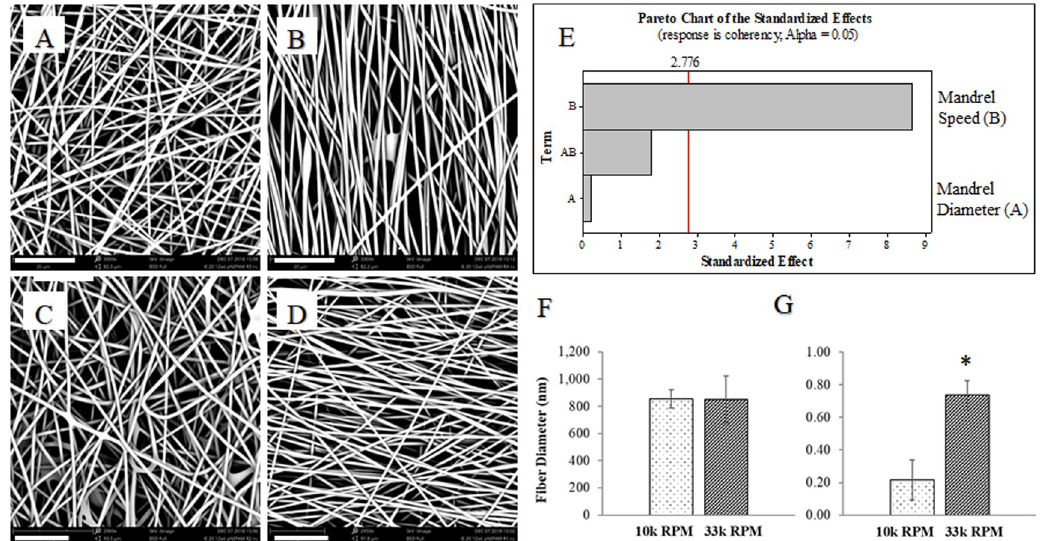
Fig 3. Effect of mandrel diameter and speed on fiber diameter and coherency. (A) 0.156” (4mm) mandrel diameter, 10,000 RPM. (B) 0.156”, 33,000 RPM. (C) 0.195”, 10,000 RPM. (D) 0.195”, 33,000 RPM. (E) Factorial design analysis shows mandrel speed to be a significant factor on Coherency (alignment). (F) Fiber diameter and (G) Coherency of nanofibers spun at 33,000 RPM and mandrel diameter 0.156”. Scale bar (lower left of each image) is 20 μ m. � p < 0.05 by 2-sample